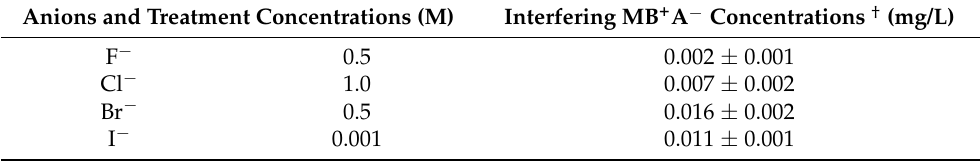
Table 2. Effect of washing with Ag 2 SO 4 on reduction of interference by halides in MIBK-DCE extraction